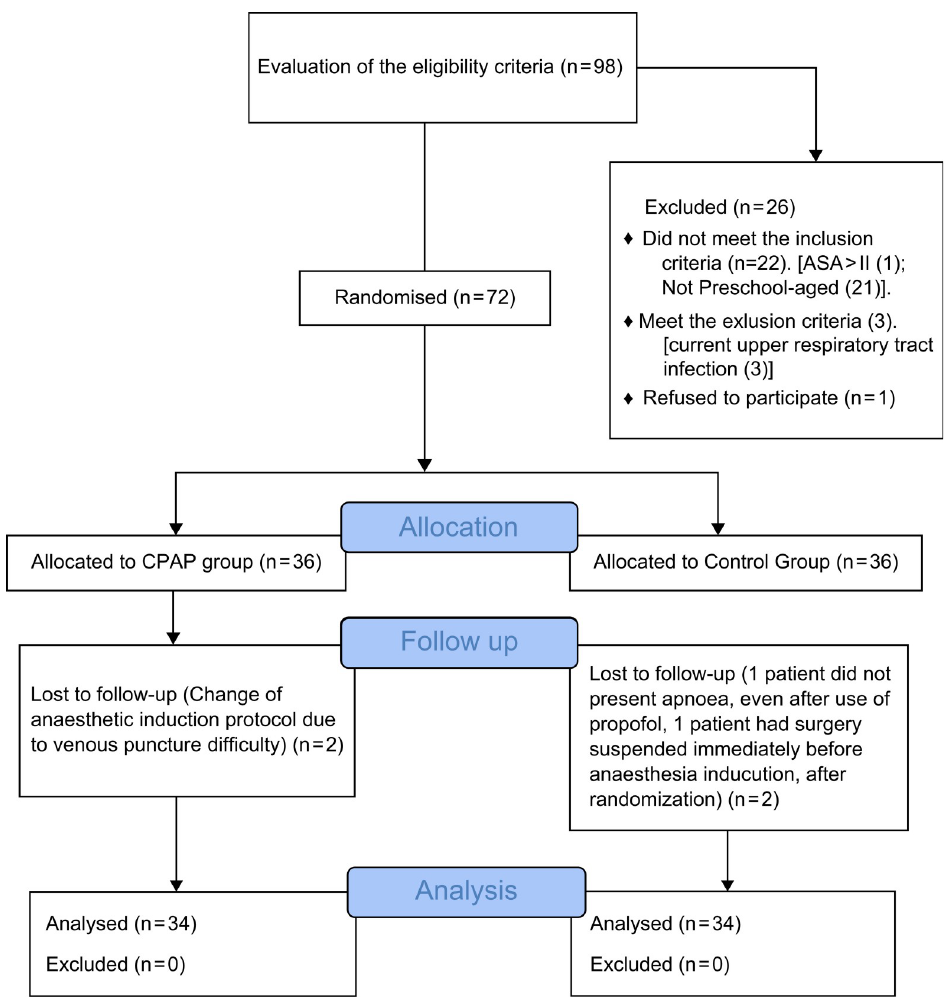
Fig 1. CONSORT diagram of patient